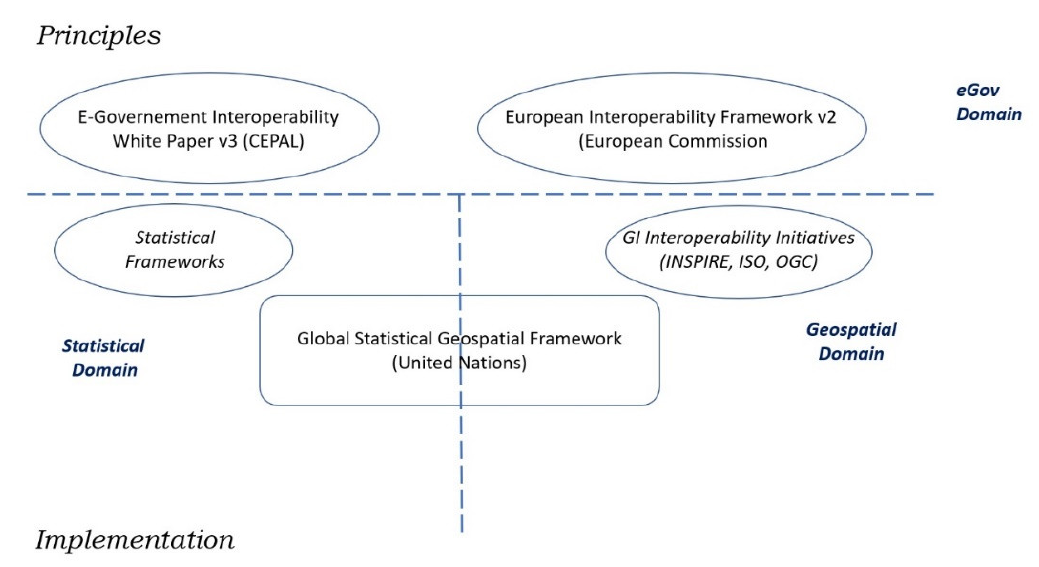
Figure 1. Relationship between electronic government and the statistical and geospatial domains.